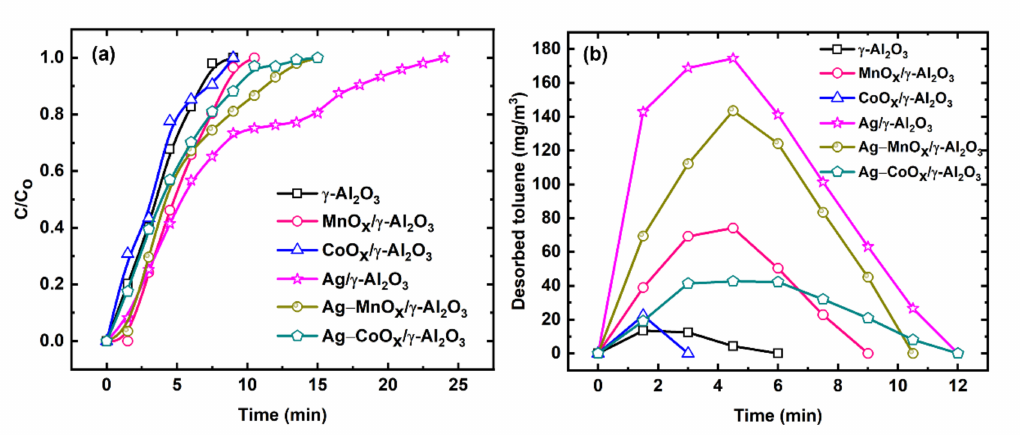
Figure 5. ( a ) Breakthrough curves of toluene; ( b ) amount of toluene desorbed as a function of time during ozone treatment of the